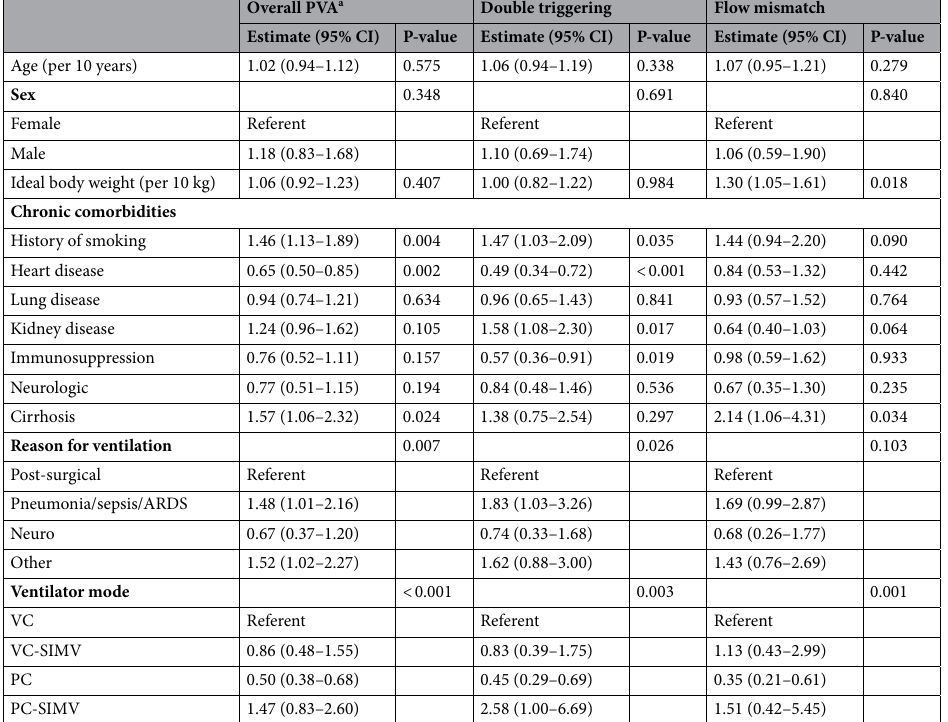
Table 2. Association of PVA with baseline patient characteristics using PWP-GT model. PWP-GT model : Prentice, Williams, and Peterson gap time. Robust sandwich variance estimates were used to account for the potential within patient correlation. For each model, the terms were assessed for collinearity and functional form. a Overall PVA included flow starvation, double triggering, ineffective effort, delayed triggering and cycle